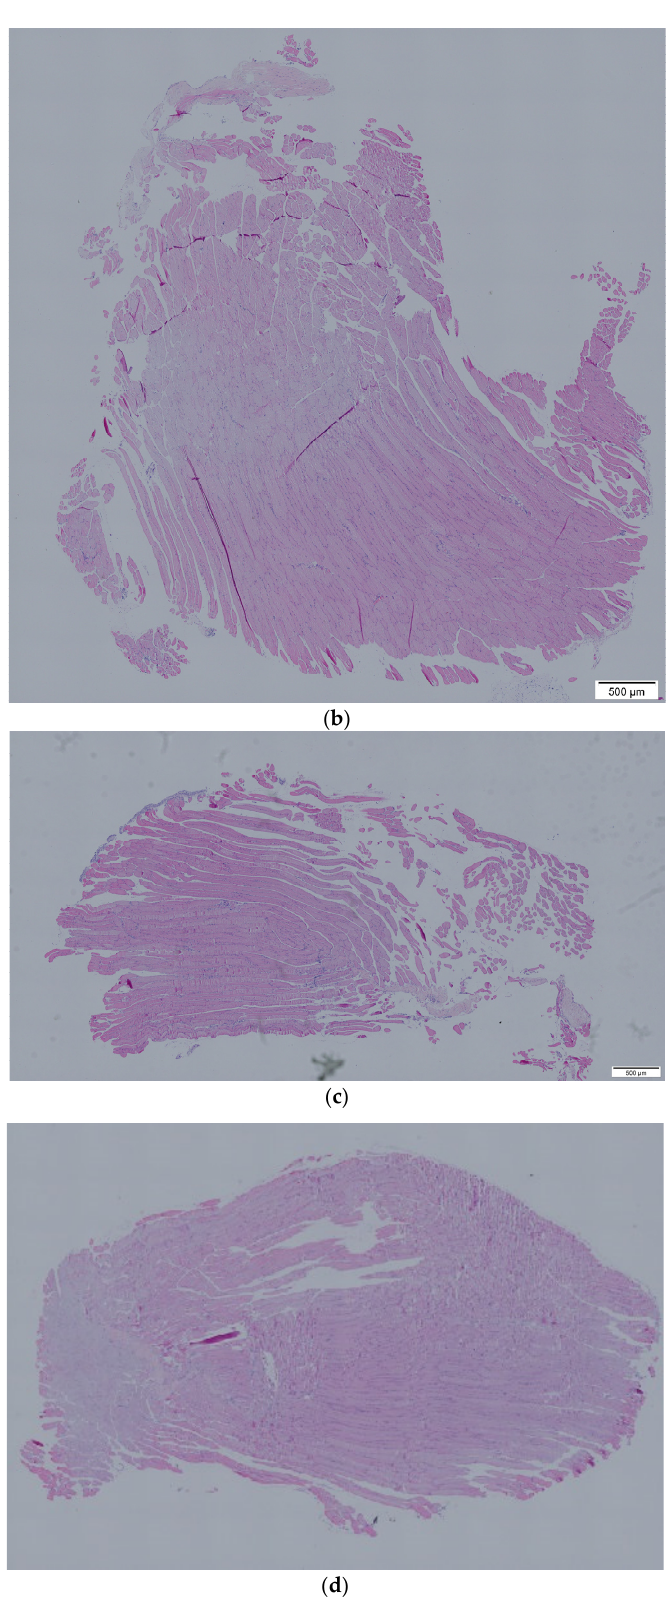
Figure 2. Histological imaging of formalin-fixed KNO 3 -fed mouse EDL part tissue slices 21 days after treatment. ( a , c )—control group; ( b , d )—KNO 3 -fed group. The magnified histological experiment staining images are in the Supplementary Materials (Figure S2).